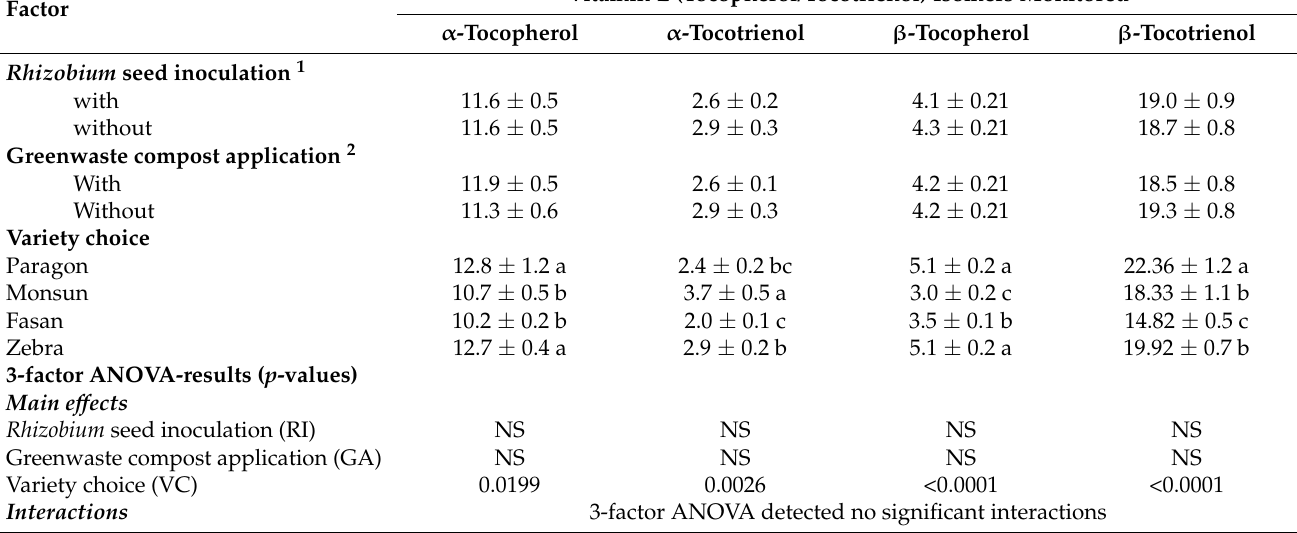
Table 13. Effect of clover ley managerment ( Rhizobium inoculation of clover seed and greenwaste compost applications) on Vitamin E (tocopherol and tocotrienol isomers) concentrations ( µ g g − 1 ) in grain from contrasting spring wheat varieties established after two year clover leys. Values shown are main effect means ±